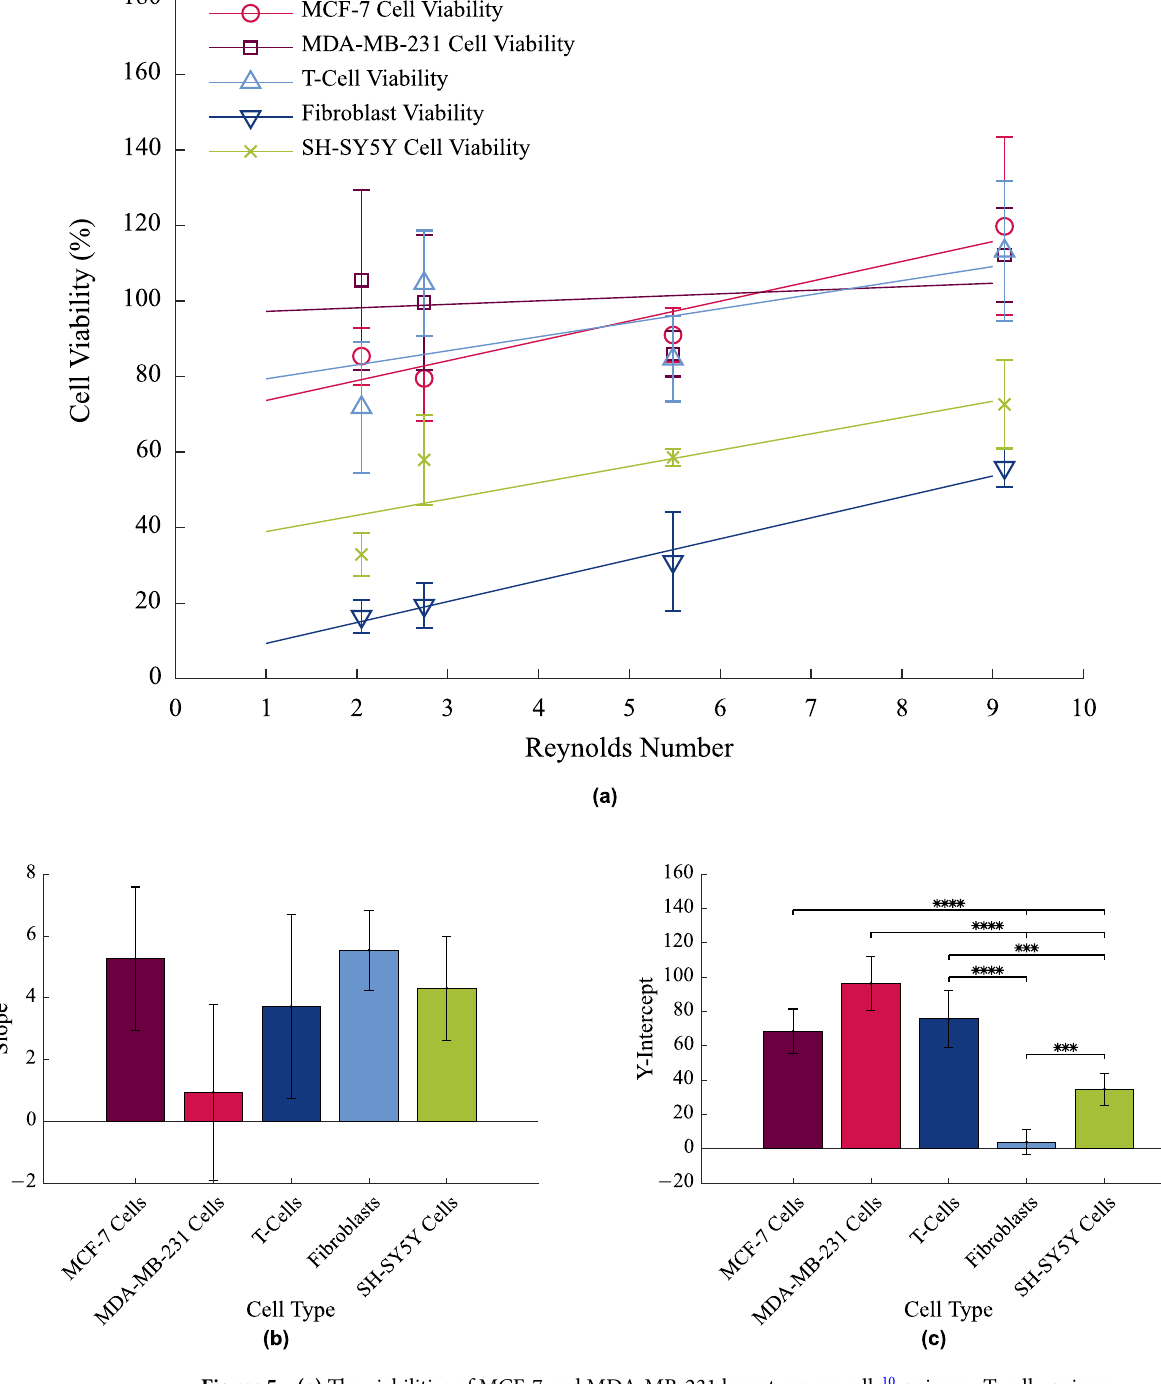
Figure 5. (a) The viabilities of MCF-7 and MDA-MB-231 breast cancer cells 10 , primary T-cells, primary porcine intestinal fibroblasts and SH-SY5Y neuroblastoma cells in circulation with fitted viability lines. All viabilities are presented as a percentage of the control viability. (b) A comparative analysis of the slopes of viability. Statistical analysis was conducted using linear regression analysis. Vertical bars represent the s.e.m. (c) A comparative analysis of the elevations of viability. Statistical analysis was conducted using linear regression analysis. **** p < 0.0001, *** p < 0.001, vertical bars represent the